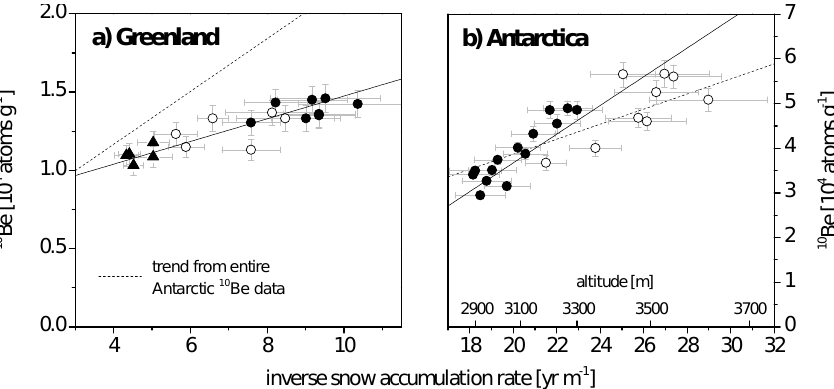
Figure 5. Spatial distribution of mean 10 Be firn concentrations measured within (a) Greenland and (b) Antarctic traverses. While solid lines denote linear fits to the above measurements, dashed lines depict the linear fit to Antarctic-wide data shown in Fig. 4. In both cases, Greenland and Antarctica, different symbols denote different traverse surveys: (a) NGT west ( • ), NGT east ( (cid:78) ), EGIG east ( ◦ ). (b) Kohnen upstream ( • ), JASE ( ◦ ) (see Sects. 2.3 and 2.4 for details).